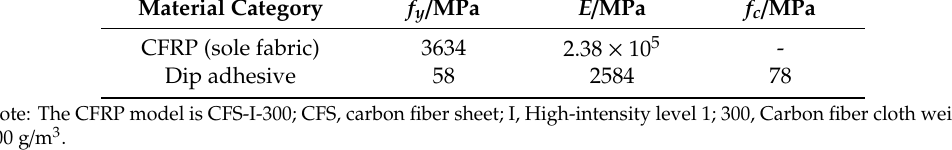
Figure 2. performance test of CFRP cloth. Table 2. Properties of materials.